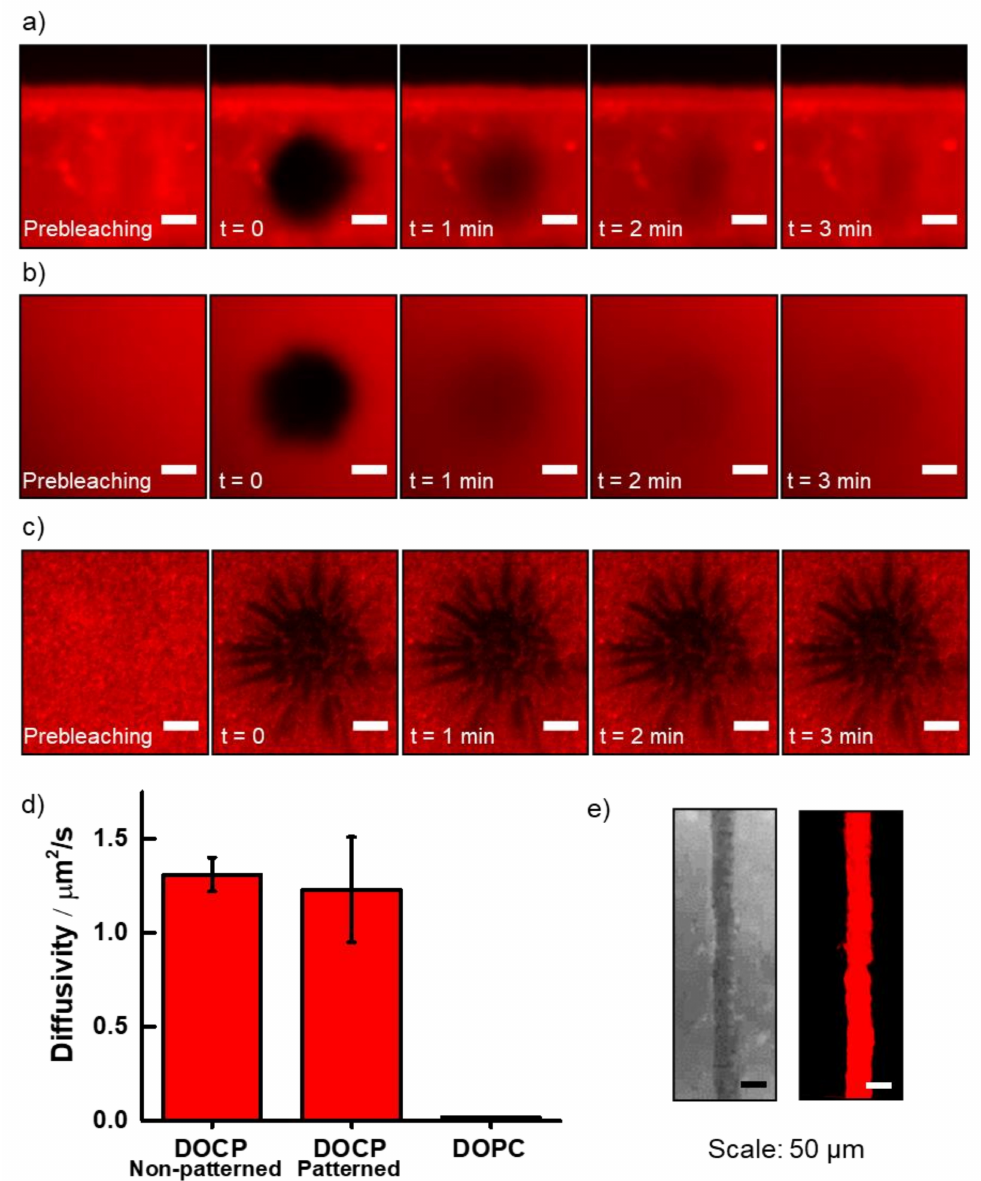
Figure 4. Fluorescence recovery after photobleaching (FRAP) experiments to measure lateral phos- pholipid diffusion in tethered lipid bilayer pattern on a TiO 2 surface: ( a ) Photobleaching and time- dependent recovery of inkjet-printed phospholipid bilayers in micropatterns. The fluidity of the DOCP phospholipids confirms that the lipids exhibit a fluidic membrane character. ( b ) Photobleach- ing and recovery of DOCP phospholipid bilayer prepared by vesicle fusion across a TiO 2 surface. ( c ) Photobleaching without recovery for a DOPC intact vesicle adlayer on a TiO 2 surface. FRAP image scale bars: 10 µ m. ( d ) Diffusion coefficients of DOCP lipid bilayer fabricated by inkjet printing ( a ) compared with DOCP lipid bilayer fabricated by vesicle fusion ( b ) and DOPC lipid bilayer fab- ricated by vesicle fusion ( c ). ( e ) DOCP printed line captured in lower magnification with a camera ( left ) and with a fluorescence microscope ( right